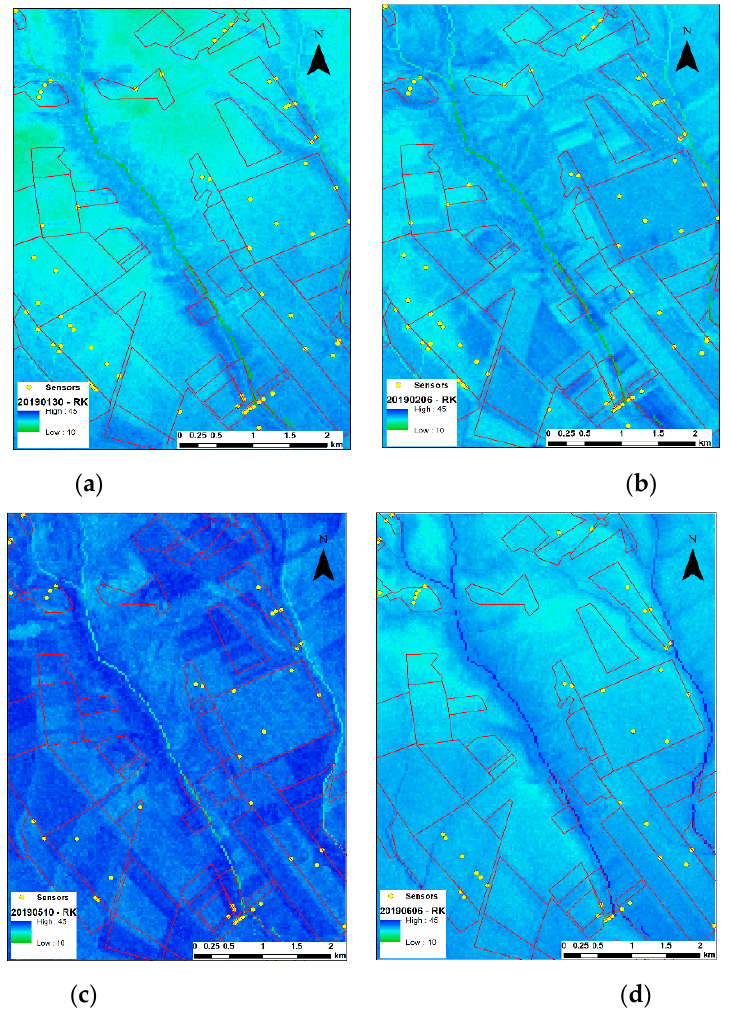
Figure 9. All land uses: Error-corrected prediction regression kriging soil moisture map (V%)—( a ) January 2019, ( b ) February 2019, ( c ) May 2019, and ( d ) June 2019, respectively. Predicted SM for wheat land use